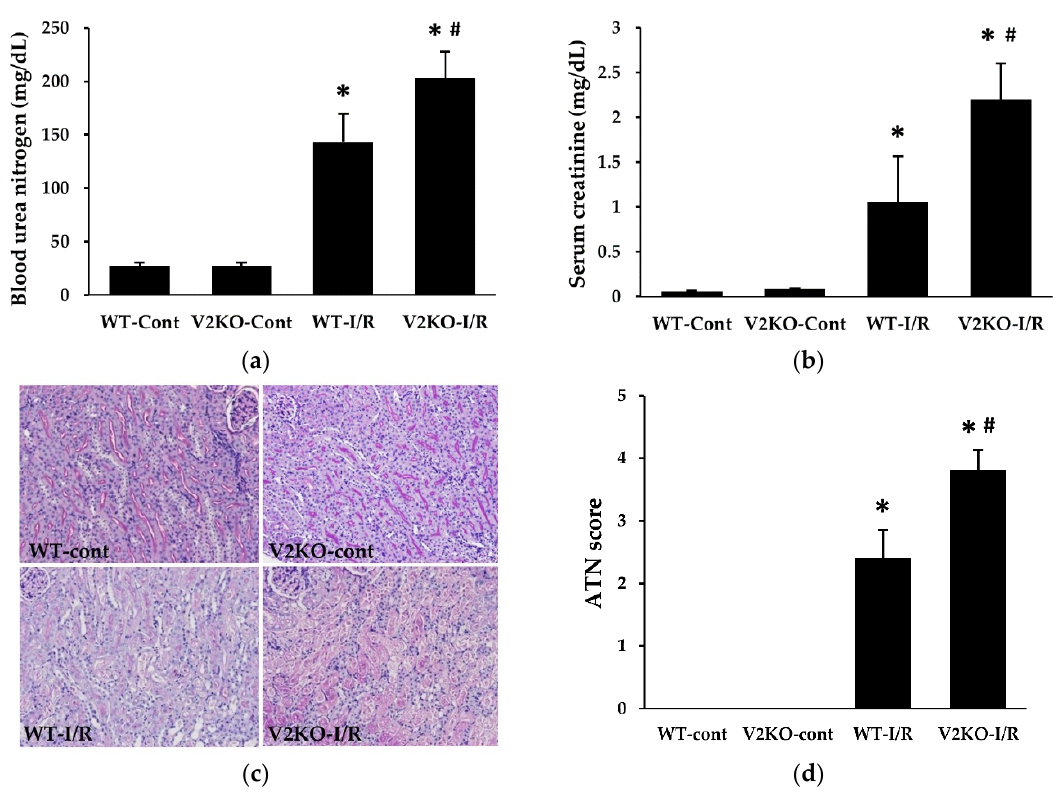
Figure 1. Vasohibin-2 (VASH2) deficiency accelerated ischemia–reperfusion (I/R)-induced renal dysfunction and renal tubular injury. The increase in serum levels of blood urea nitrogen (BUN) ( a ) and creatinine ( b ) induced by I/R injury was higher in V2KO mice than WT mice; ( c ) light microscopy images of the renal corticomedullary areas (periodic acid-Schiff (PAS) staining, original magnification, × 200). ( d ) Acute tubular necrosis (ATN) score was calculated based on the percentage of damaged tubules. n = 6 for each group. * p < 0.01 vs. WT-cont, # p < 0.05 vs. WT-I/R. Each column shows the mean ± standard deviation (SD).